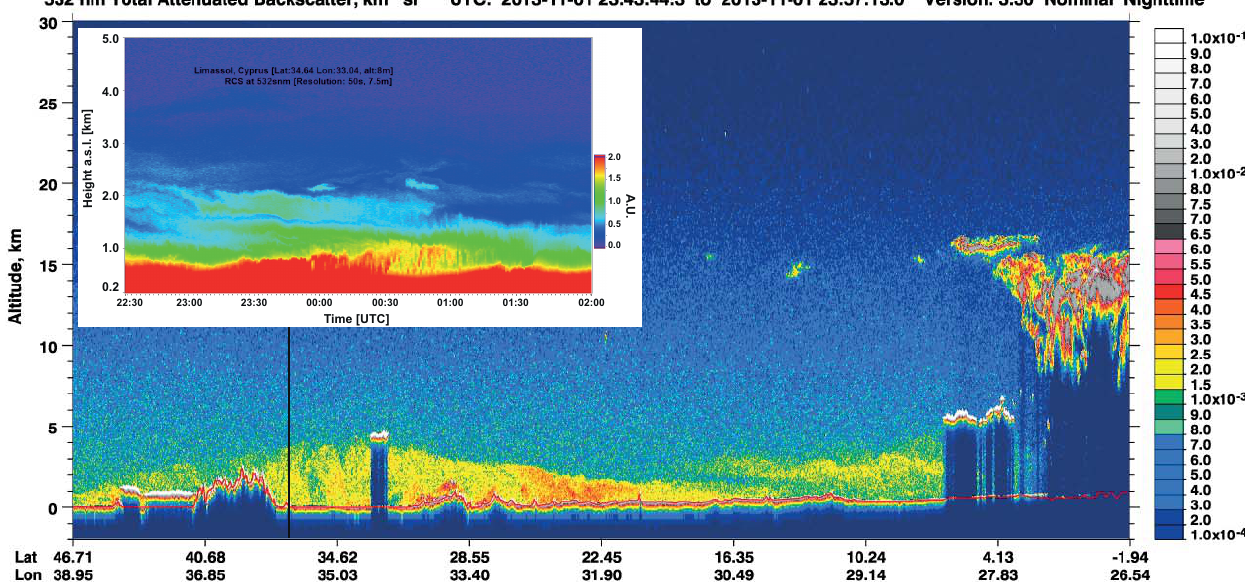
Figure 11. CALIOP measurement (height versus latitude/longitude display) of the attenuated 532nm particle backscatter coefficient during an overpass 180km to the east of Limassol on 1 November 2013, 23:43–23:57UTC. Desert dust layers are given in green to yellow colors and reach up to about 4km height. The inserted height-time display shows the CUT lidar observation of the cross-polarized range-corrected 532nm backscatter signal from 1 November 2013, 22:30, to 2 November 2013, 02:00UTC. The vertical black line indicates the closest position of CALIOP (laser footprint) to the ground-based CUT lidar at Limassol, Cyprus.